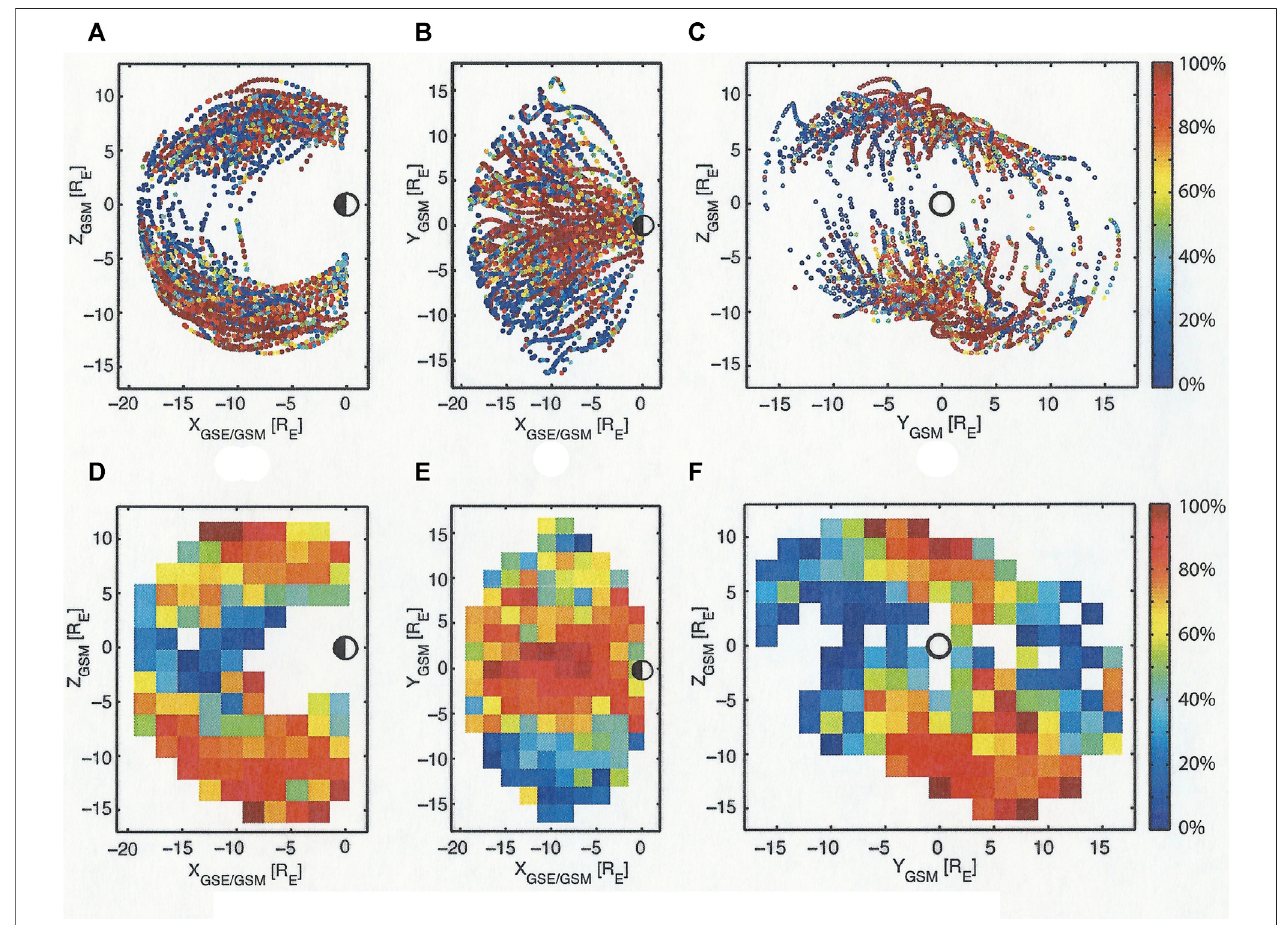
FIGURE 7 | Measurements of the polar wind in the lobes of the magnetotail using the spacecraft wake from a group of plasma and fi eld instruments on Cluster.